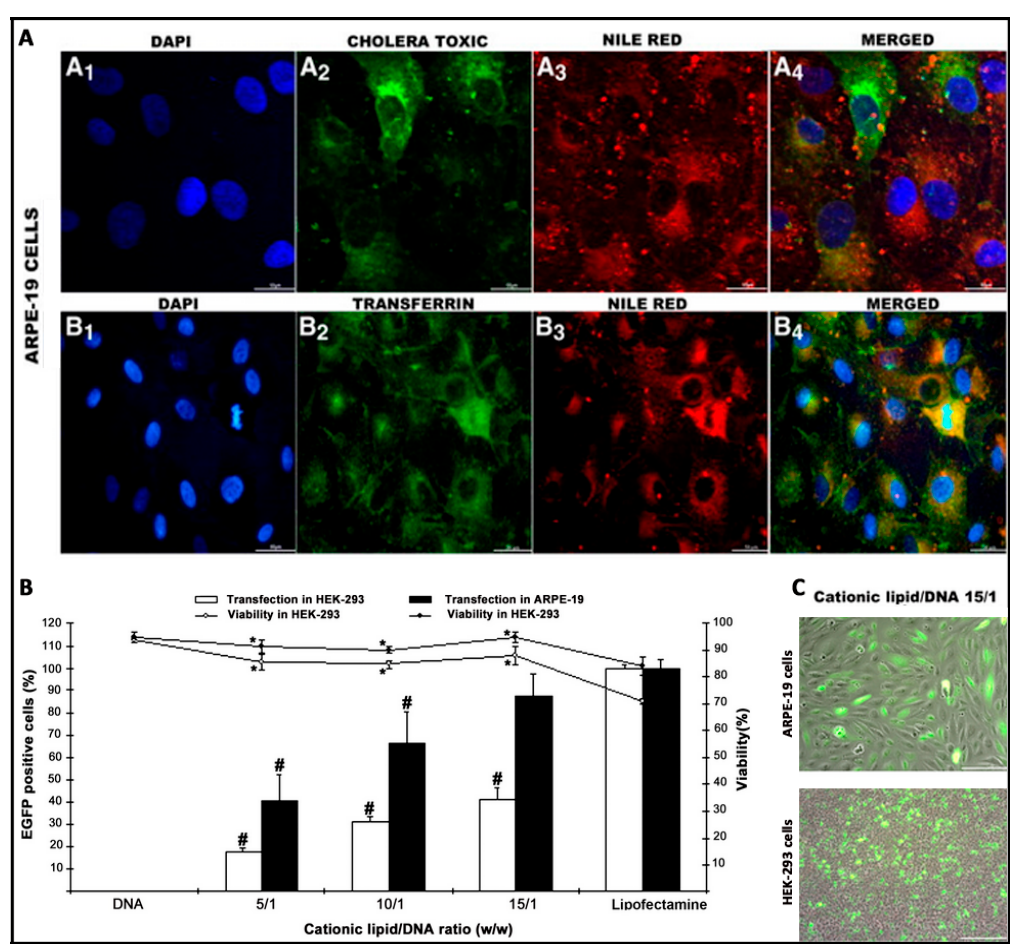
Figure 5. Biological evaluation of niosomes in terms of intracellular trafficking ( A ), transfection efficiency ( B ), and morphology ( C ), adapted with permission from Puras et al. [91]. Copyright 2014, Elsevier B.V.